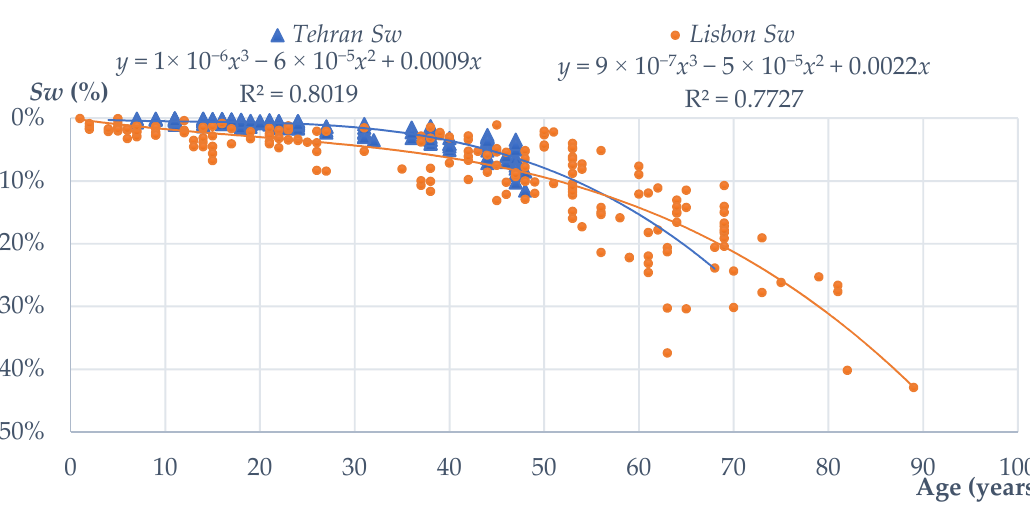
Figure 8. Degradation curves of the Tehran and Lisbon samples.